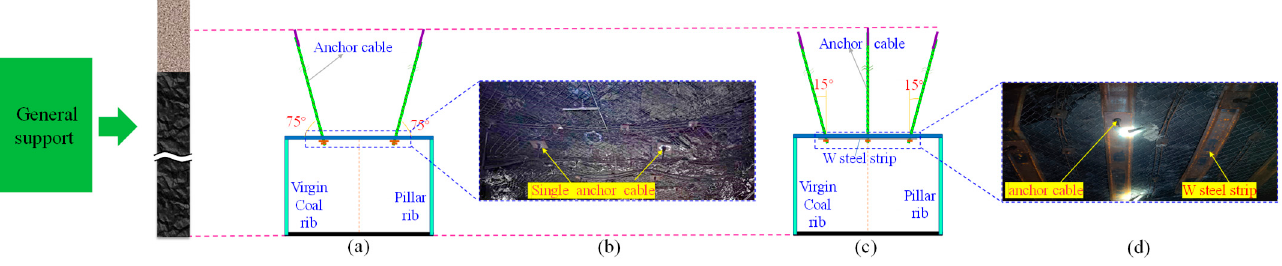
Figure 24. The roof support of gob-side entry driving: ( a ) single anchor cable support, ( b ) on-site support diagram, ( c ) anchor cable + W steel strip support, ( d ) on-site support diagram, ( e ) symmetric cable truss support, ( f ) asymmetric cable truss support, ( g ) connecting lock device, ( h ) supporting principle diagram, ( i ) asymmetric double anchor cable support, ( j ) cable truss + single anchor cable support, ( k ) on-site support diagram, ( l ) supporting principle diagram, ( m ) channel steel + four an- chor cables support, ( n ) channel steel + five anchor cables support, ( o ) on-site support diagram, ( p ) supporting principle diagram, ( q ) single-step bundled anchor cable support, ( r ) step bundled anchor